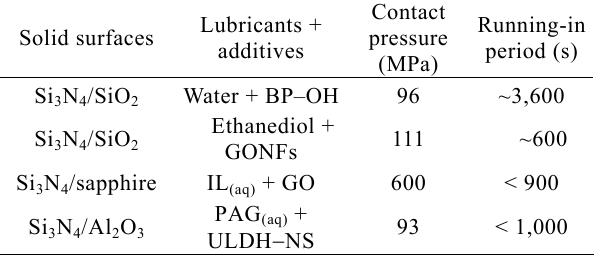
Table 2 Liquid superlubricity systems with different sliding solid surfaces, liquid lubricants, nano-additives, final contact pressure (MPa), and running-in period (s) in superlubricity